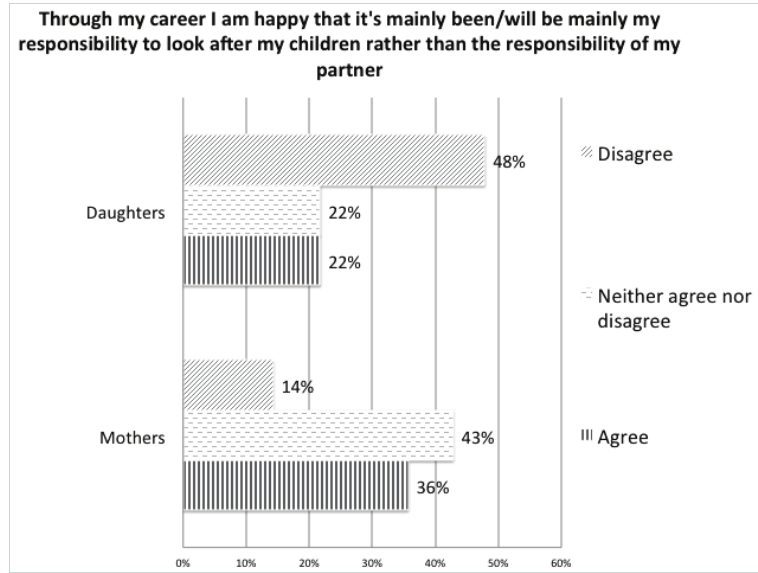
Figure 1: Responsibility for children (n.